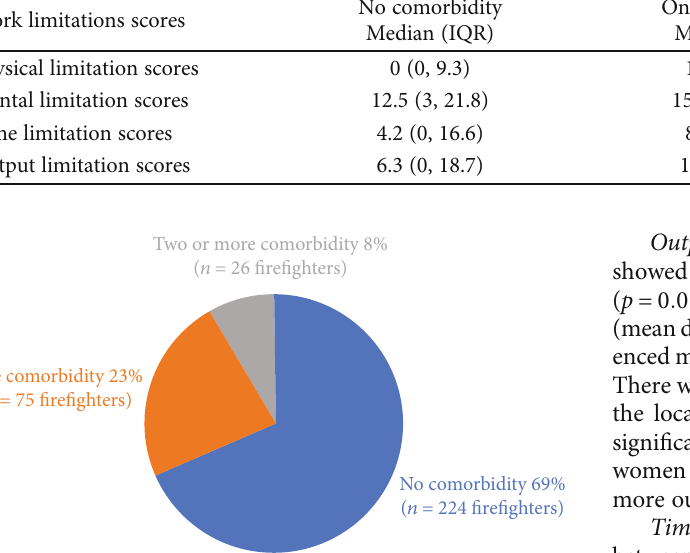
Figure 5: Number of comorbidities.